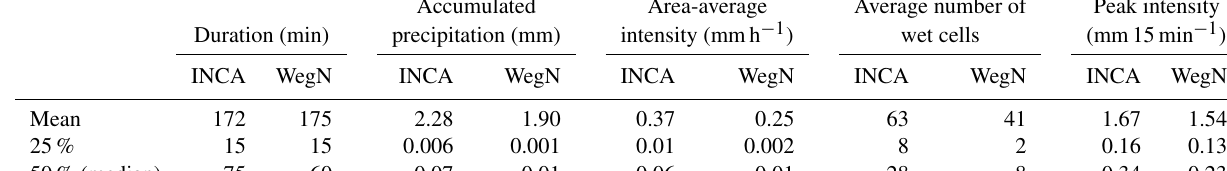
Table 3. Descriptive statistics for separate events in INCA and WegenerNet based on the 1h interval (based on definitions in Sect. 3.2).